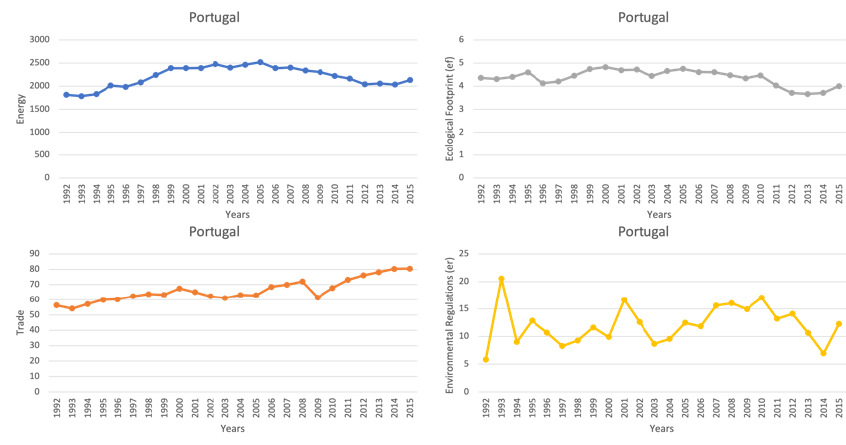
Figure 3. Data visualization for Portugal.